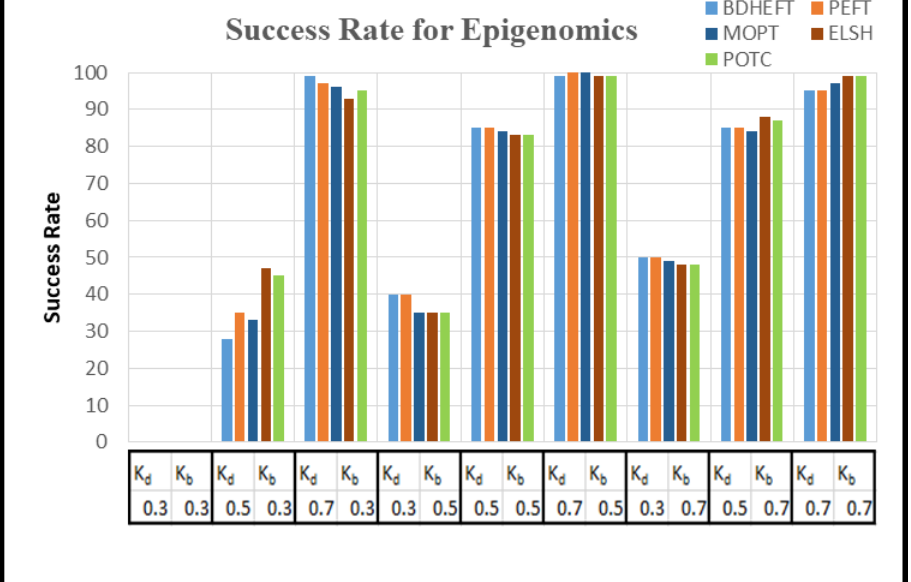
Figure 8. Success rate of the epigenomics workflow.